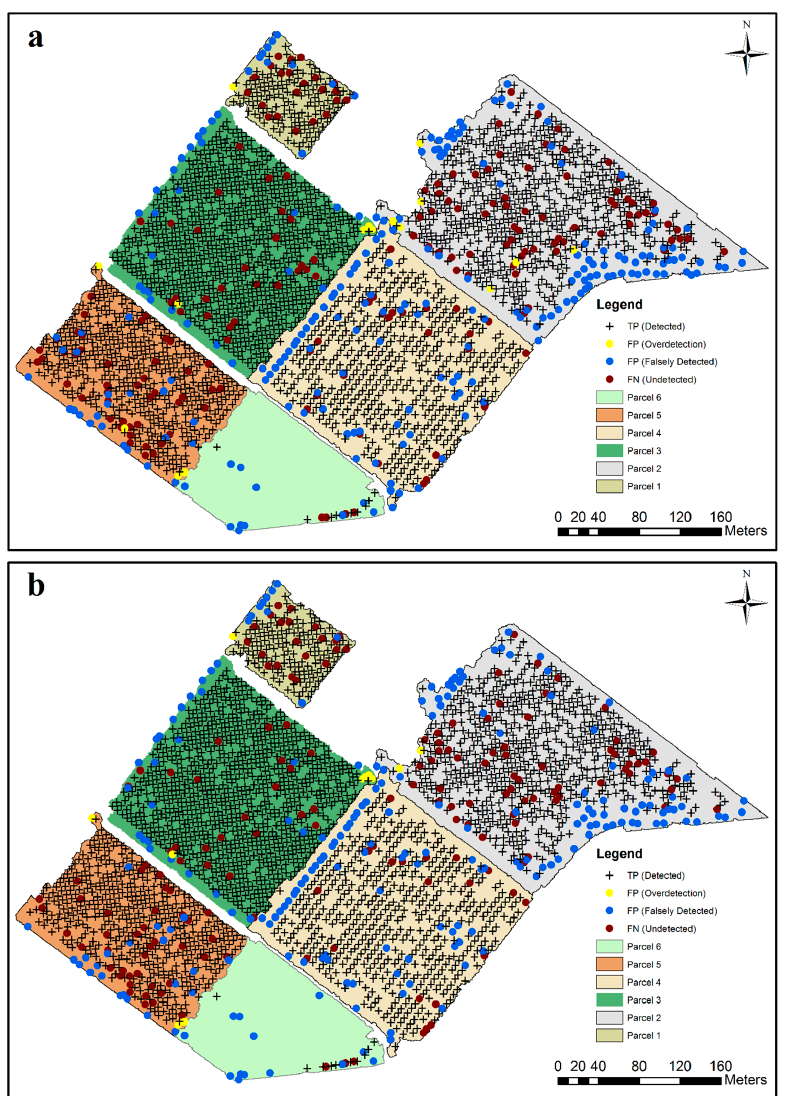
Figure 9. ( a ) Map of the ITC detection performance of the TM-CS; ( b ) map of ITC detection performance of the TM-REF.